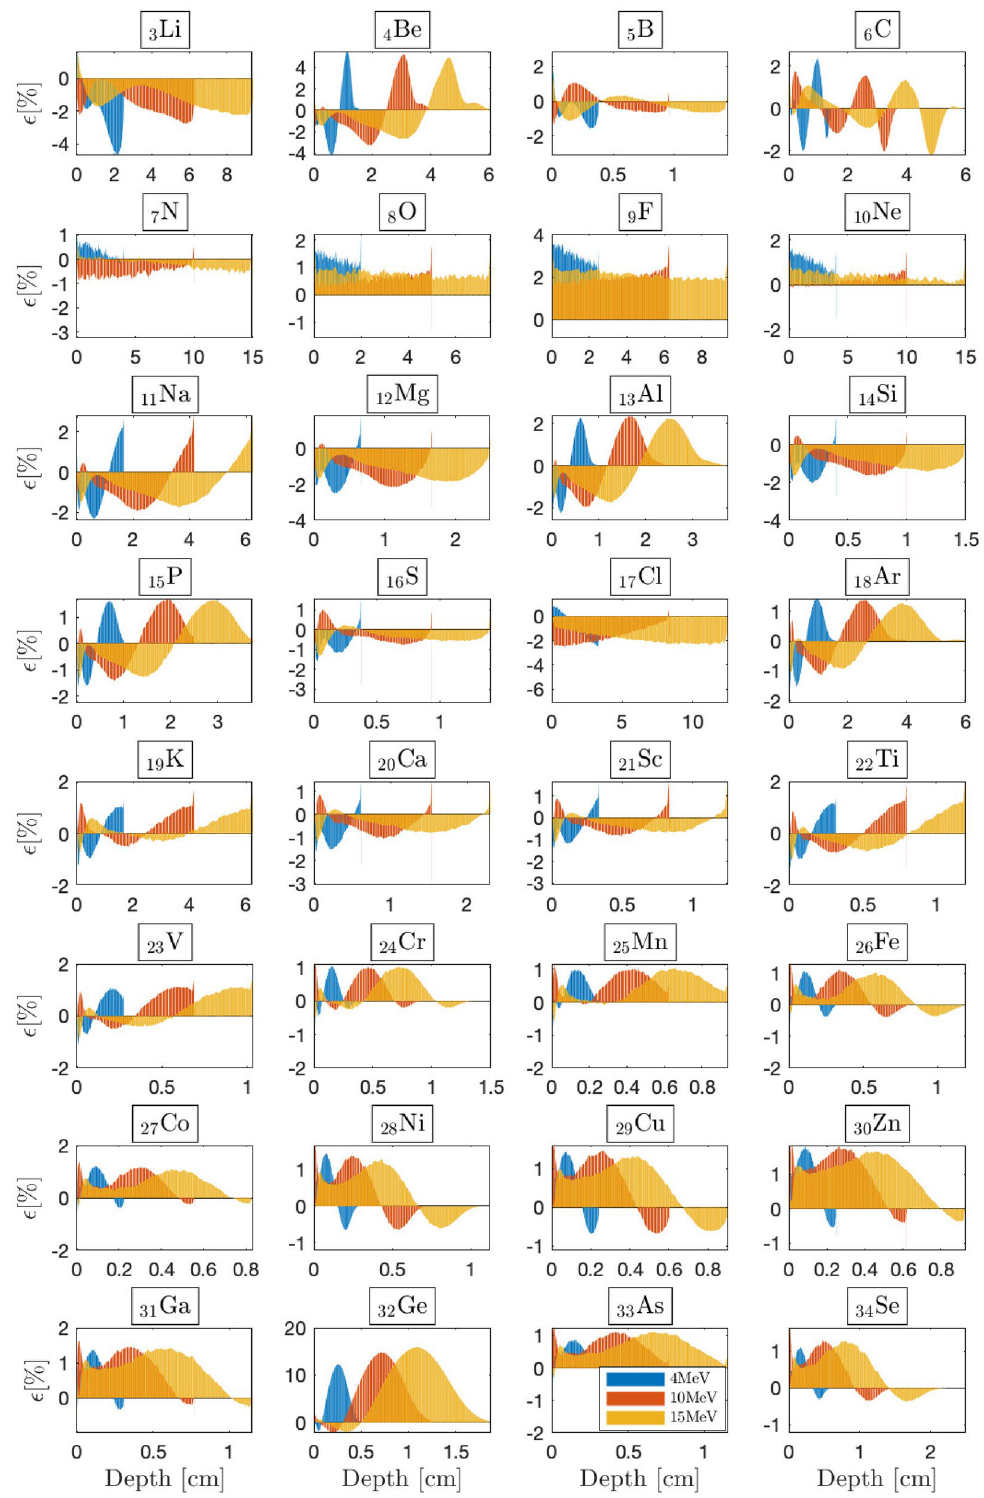
Figure 5. BFP-MC relative differences in energy deposition profiles versus depth for selected 4, 10 and 15MeV beams from Z = 3 to Z = 34 . The irradiated slabs’ dimensions are fixed to the beam’s range within the irradiated material. Monte Carlo convergences are obtained for a 0.2% mean standard